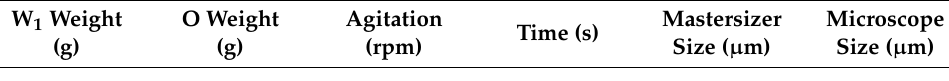
Table A2. Preparation of W 1 /O emulsion.